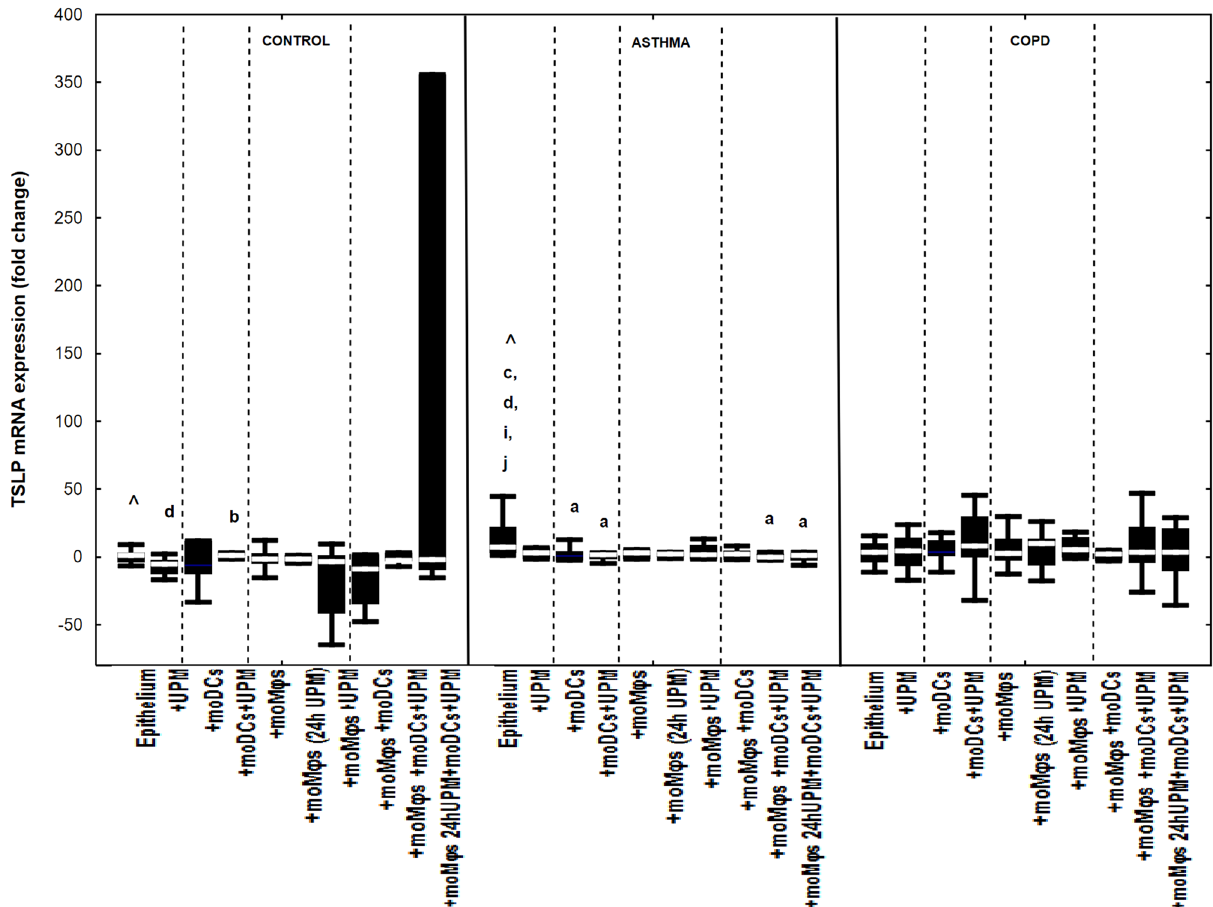
Figure 7. TSLP mRNA expression in air–liquid interface (ALI) after 24 h UPM exposure in multi co-culture schemes in control subjects, asthma and COPD patients. The data are shown as non-outlier range (whiskers), interquartile range (box) and median (line); p value calculated using Mann–Whitney U test. The p value < 0.05 in comparison to: a—epithelium, b—epithelium + UPM, c—epithelium +